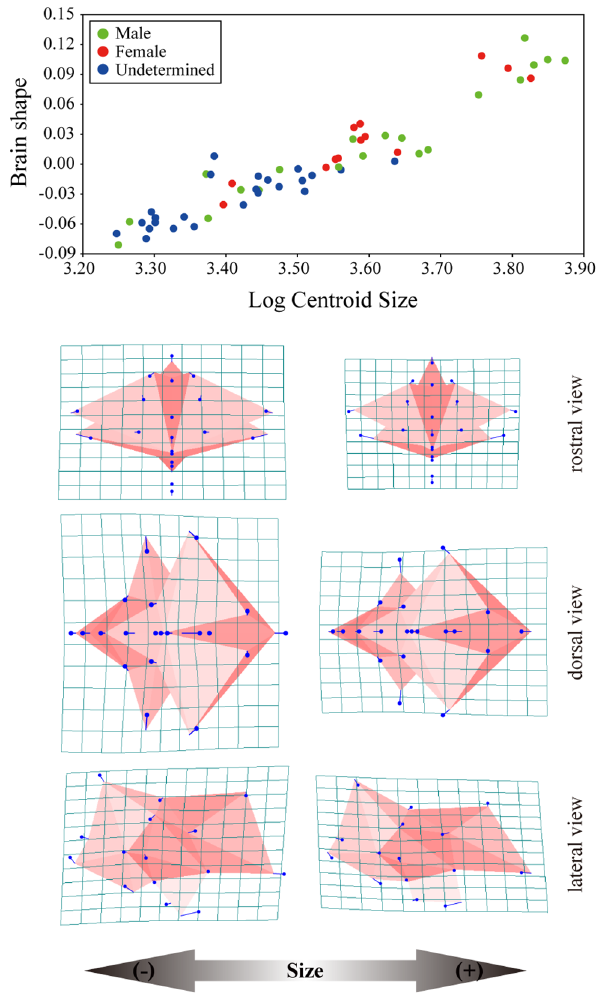
Fig 6. Multivariate regression of brain shape coordinates on log centroid